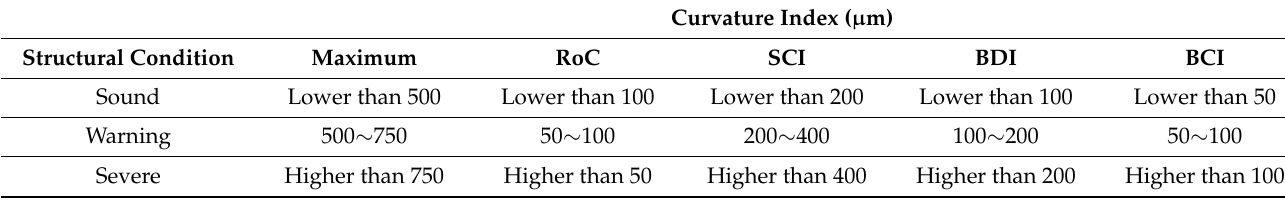
Table 8. Parameters for the functional level of the pavement.